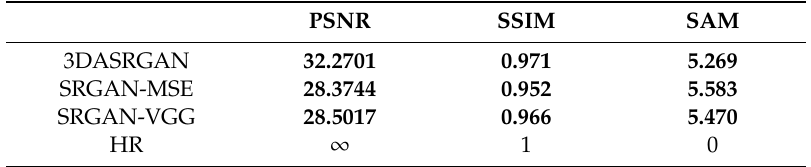
Table 3. Quantitative comparison results of 3DASRGAN and SRGAN based on the Washington DC Mall dataset.